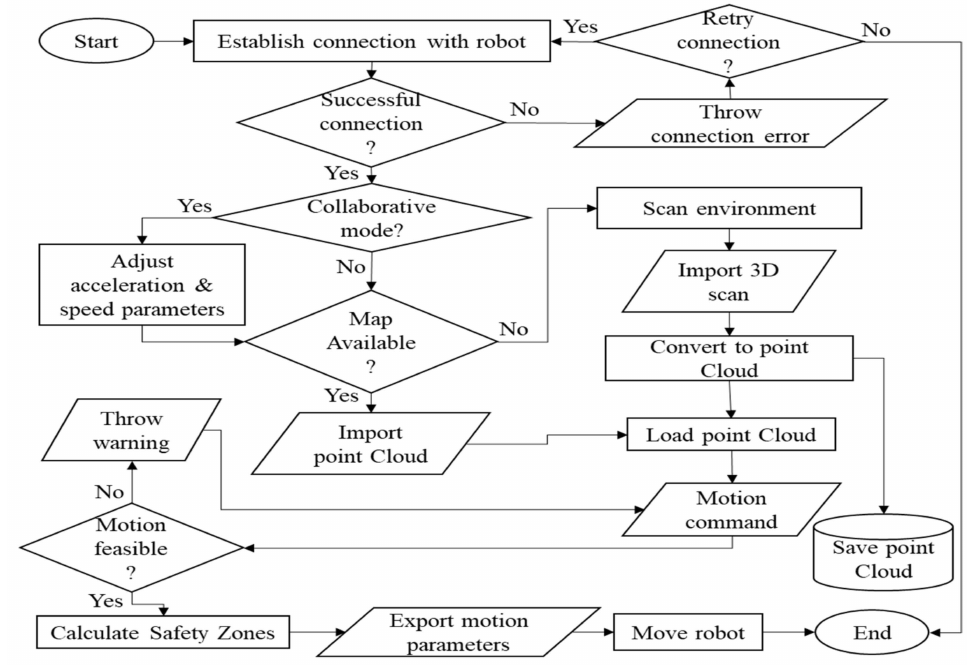
Figure 1. Flowchart of the proposed system